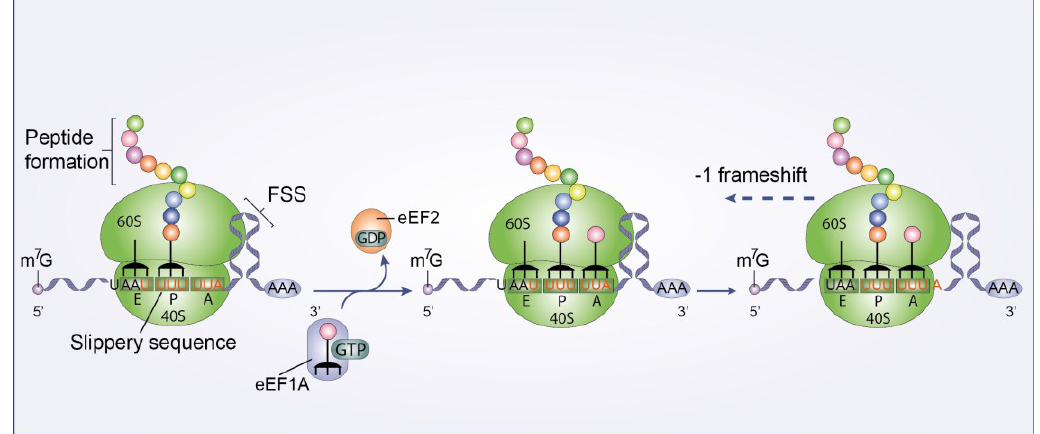
Figure 5. HIV-1 Ribosomal frameshift. A schematic diagram of the −1 nucleotide ribosomal frameshift. This process is mediated by a slippery heptanucleotide sequence (UUUUUUA) where the frameshift takes place, and an RNA element called the frameshift stimulatory signal